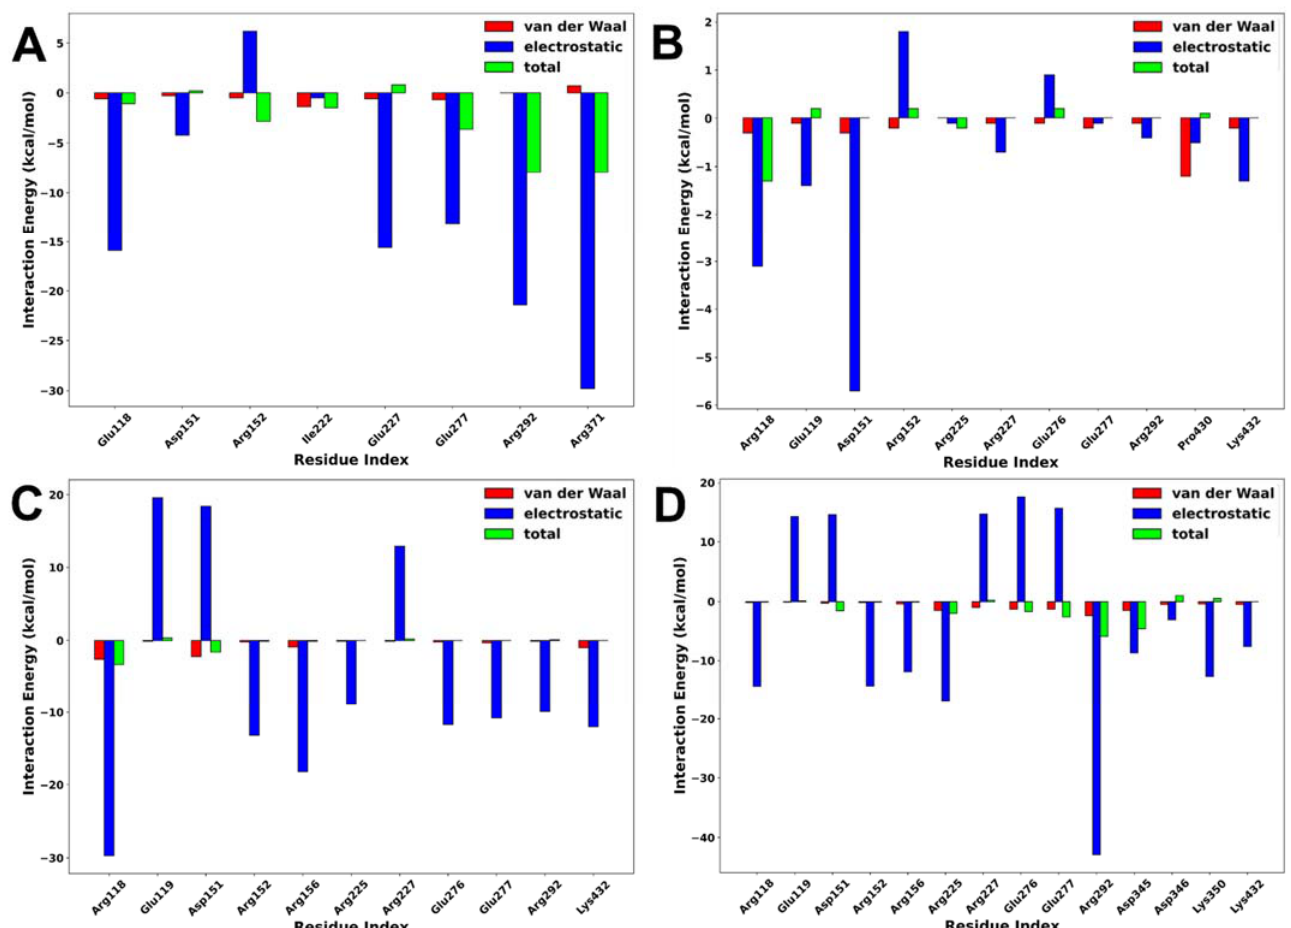
Figure 9. Interaction energy decomposition of NA complexed with peramivir ( A ), lurasidone ( B ), tucatinib ( C ), and Promacta ( D ).